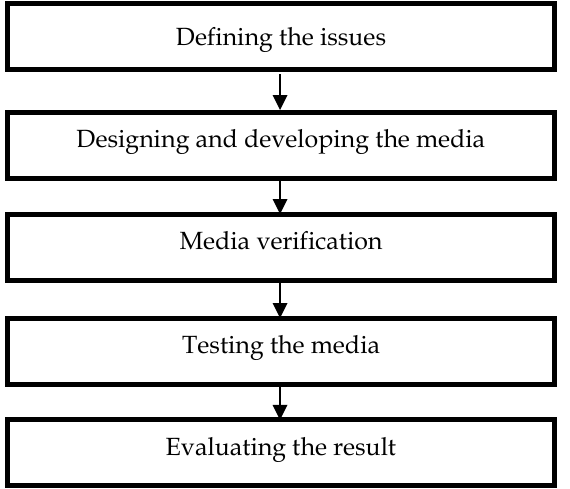
Figure 1. The steps of design and development